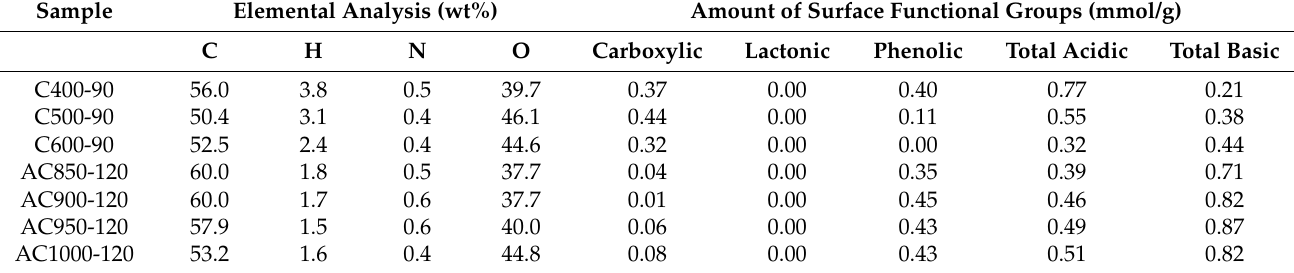
Table 4. Typical elemental analysis and surface chemistry of prepared char and the prepared activated carbon. All activated carbon samples were derived from char carbonized at 400 ◦ C for 90